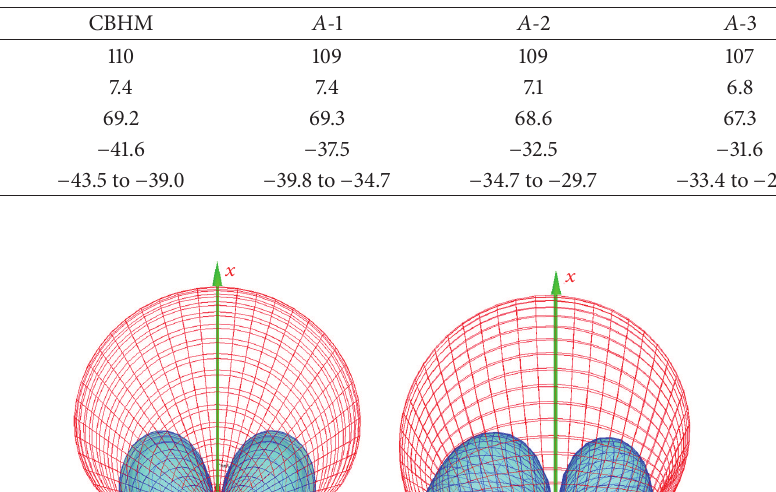
Table 4: Comparisons between CBHM and SIW antenna characteristics.